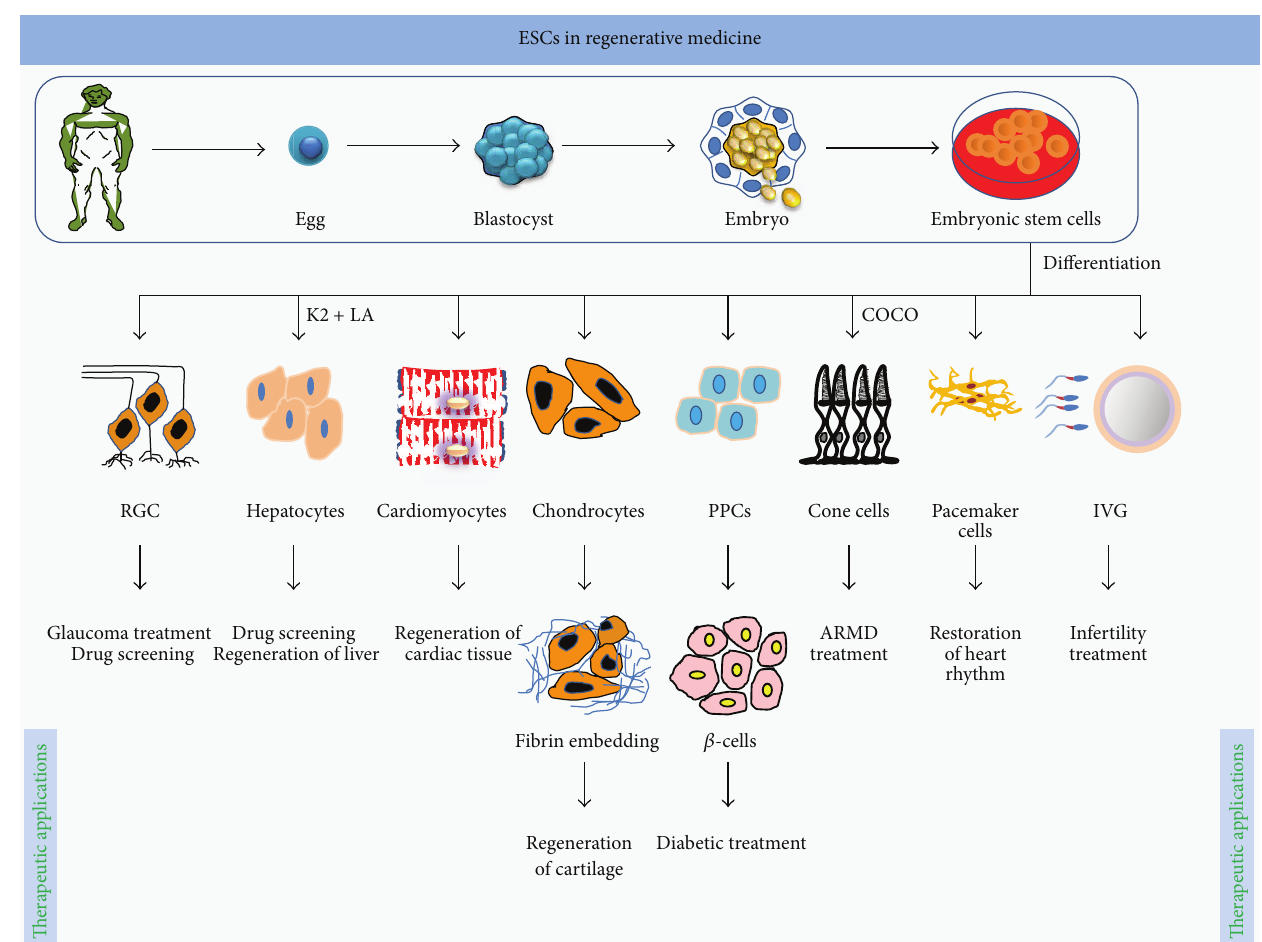
Figure 2: ESCs in regenerative medicine: ESCs, sourced from ICM of gastrula, have tremendous promises in regenerative medicine. These cells can differentiate into more than 200 types of cells representing three germ layers. With defined culture conditions, ESCs can be transformed into hepatocytes, retinal ganglion cells, chondrocytes, pancreatic progenitor cells, cone cells, cardiomyocytes, pacemaker cells, eggs, and sperms which can be used in regeneration of tissue and treatment of disease in tissue specific manner.